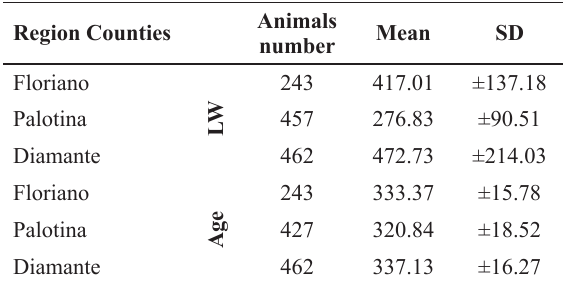
Mean and standard deviation in every experimental Region Counties